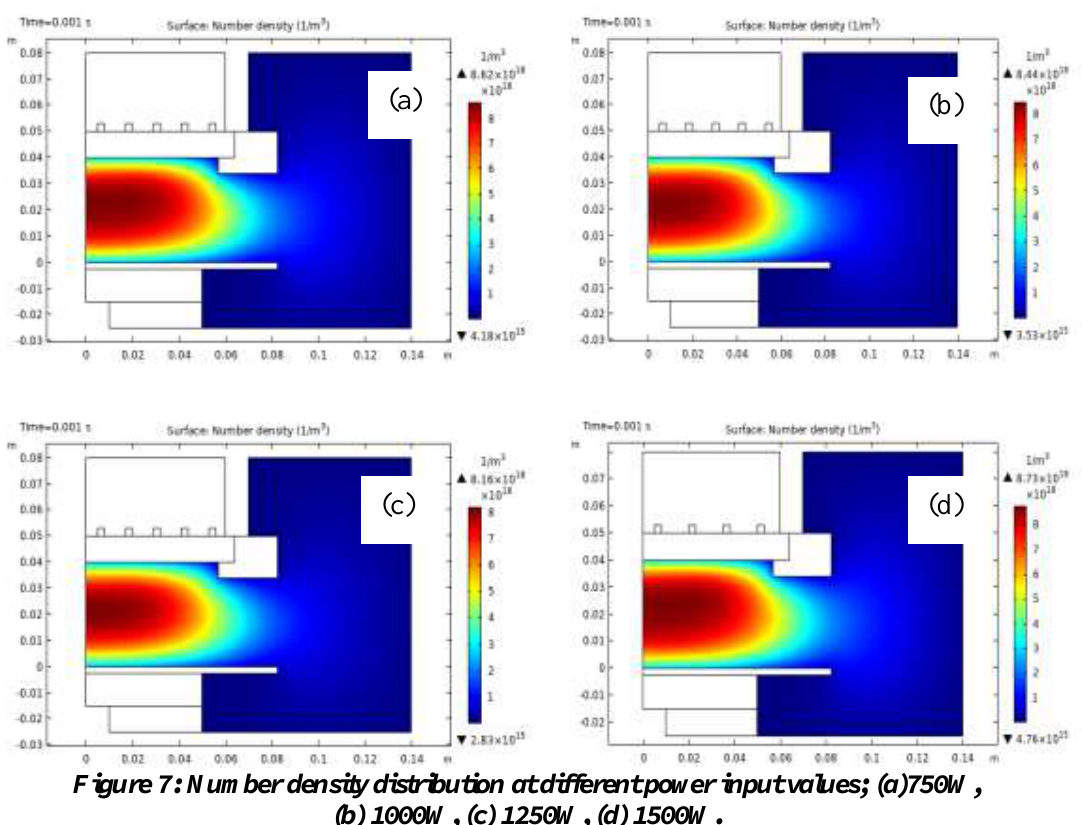
Figure 7: Number density distribution at different power input values; (a)750W, (b) 1000W, (c) 1250W, (d)